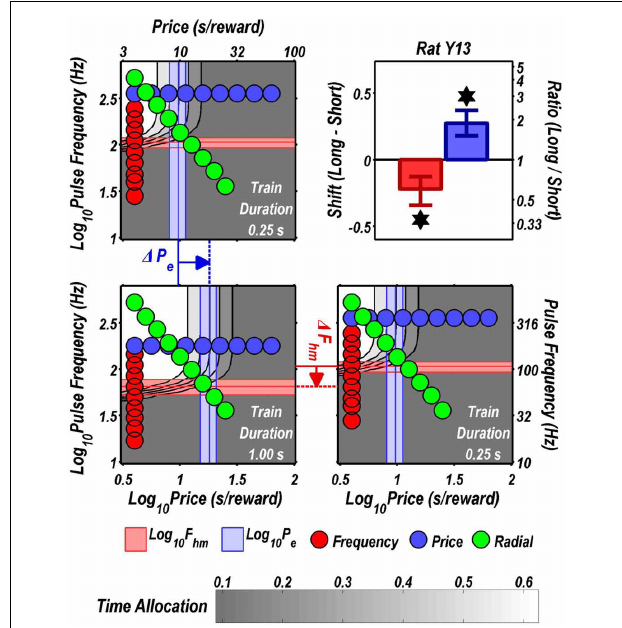
FIGURE 7 | Shifts of the reward mountain. The contour graph for the long-duration (1s) train is shown in the lower left. For comparison the contour graph for the short-duration (0.25s) train is shown twice, in the upper left and lower right. The P e parameter determines the location along the price axis, whereas the F hm parameter determines the location of the mountain along the pulse-frequency axis. The vertical blue line represents the estimate of P e , and the surrounding band represents the corresponding 95% confidence interval. The horizontal red line represents the estimate of F hm , and the surrounding band represents the corresponding 95% confidence interval. The bar graph shows the mean shifts in the location parameters due to the increase in train duration from 0.25 to 1s along with the associated 95% confidence intervals. ∗ Indicates that the 95% confidence interval does not include